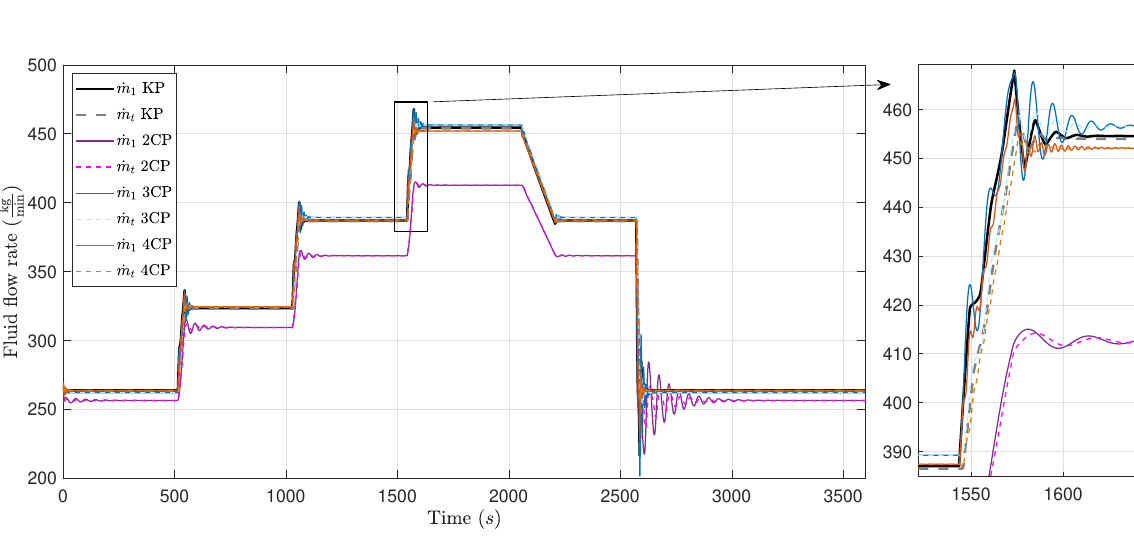
Figure 5: The mass flow rates calculated from different models for sub–critical upstream conditions. ‘KP’: KP scheme and ‘2, 3 or 4 CP’: model with 2, 3 or CPs. The subscripts 1 and t denote the first and last positions of the collocation points along the